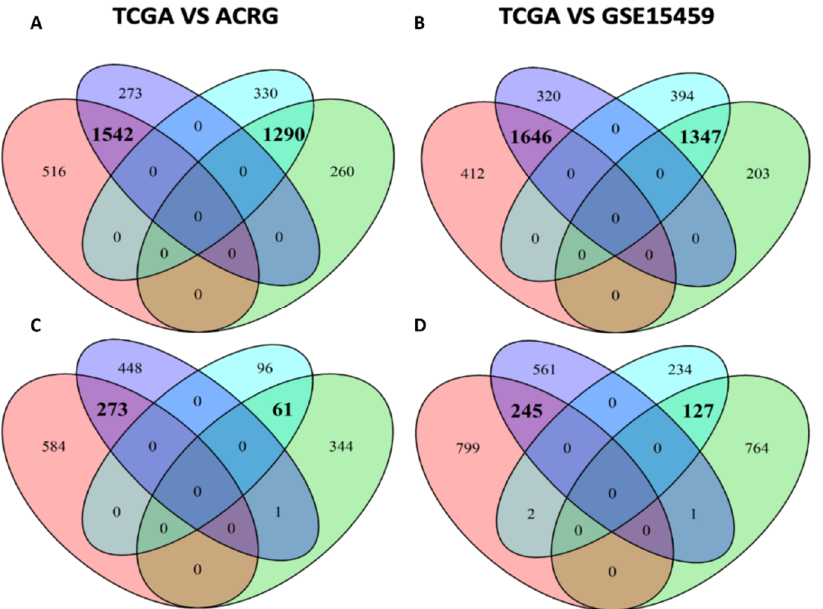
Figure 4. Venn diagrams showing the overlap between the TCGA and the validation dataset data. ( A ) The overlap of the DEGs between Diffuse vs. Intestinal subgroups in TCGA and ACRG dataset. ( B ) The overlap of the DEGs between Diffuse vs. Intestinal subgroups in TCGA and GSE15459 dataset. ( D ) The overlap of the MRs between Diffuse vs. Intestinal subgroups in TCGA and GSE15459 dataset. All overlaps in bold are statistically significant ( p -vaule <